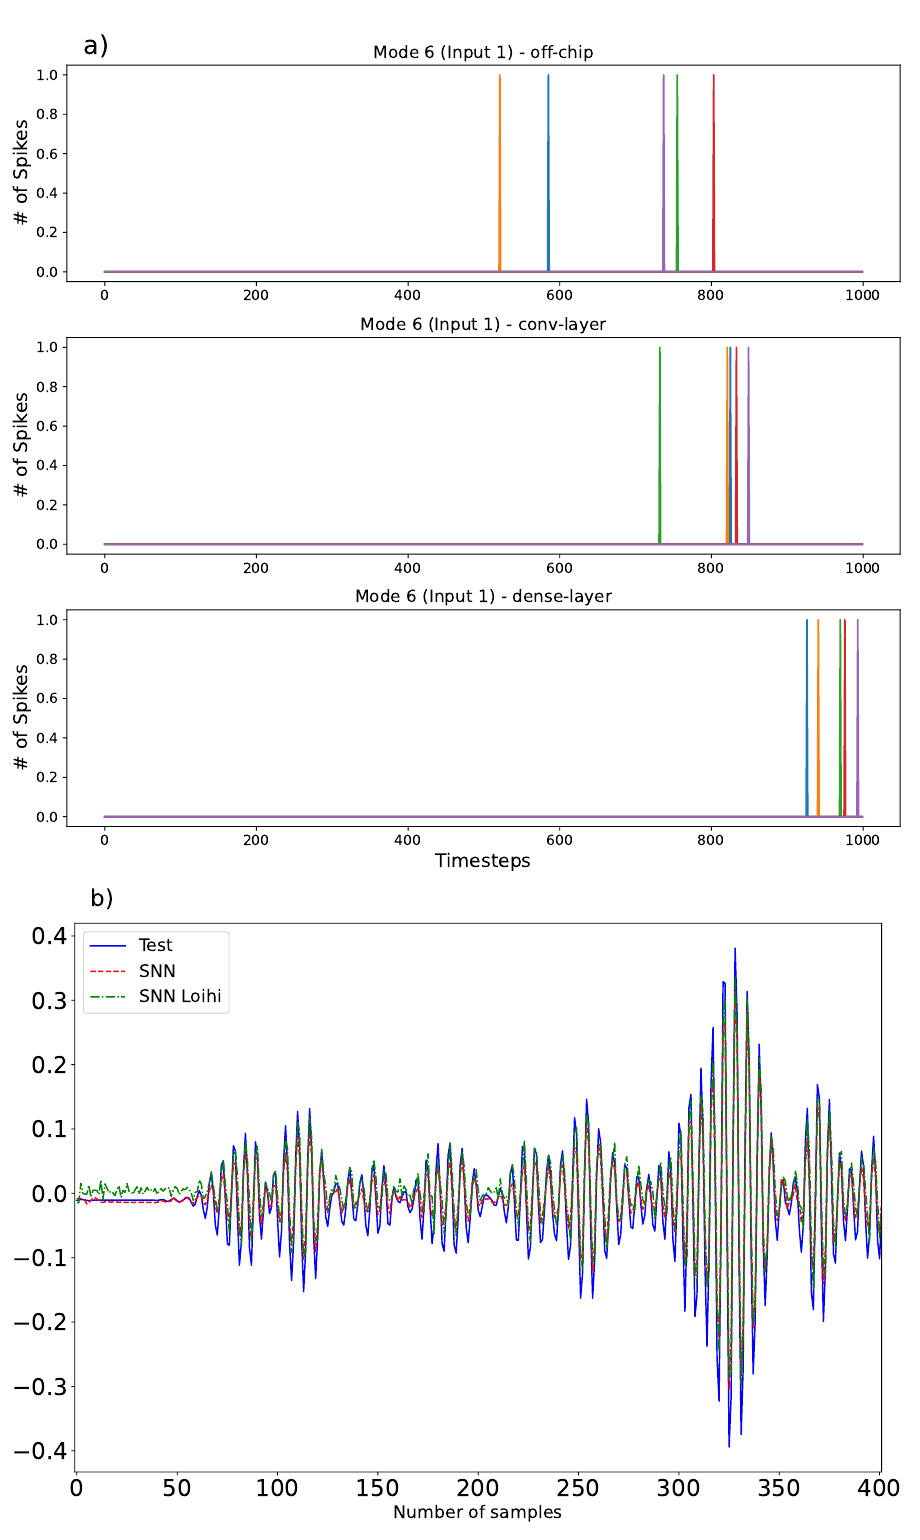
Figure 12. Results for mode 6: ( a ) Neural activities of 5 neurons of each layer. One input vector is shown over 1000 timesteps. ( b ) Predictions over the testing set with the SNN architecture (dashed red line) and running the SNN on the Loihi emulator (dash-dot green